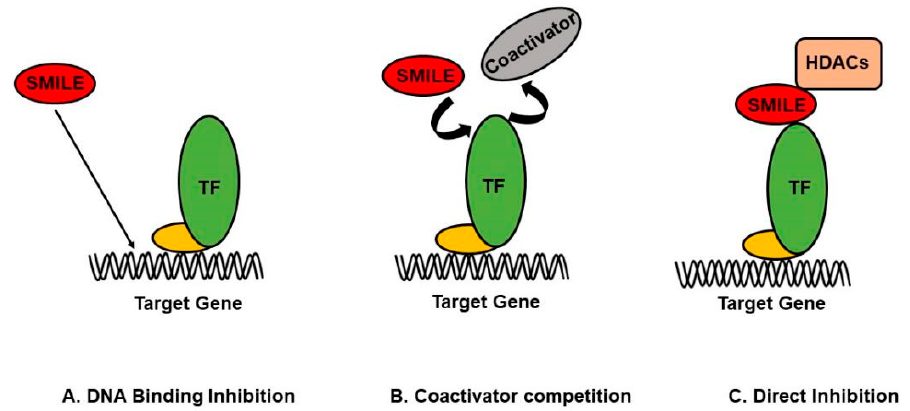
Figure 2. Modes of action of SMILE ( A ). SMILE, as a transcriptional corepressor, binds directly to DNA and inhibits target gene transcription. ( B ). Target gene expression is regulated by the corepressor SMILE and several coactivators competing to bind to the transcription factors. ( C ). SMILE recruits enzymes such as histone deacetylases (HDACs) to inhibit the transcription of target genes upon binding to the transcription factor as a complex.